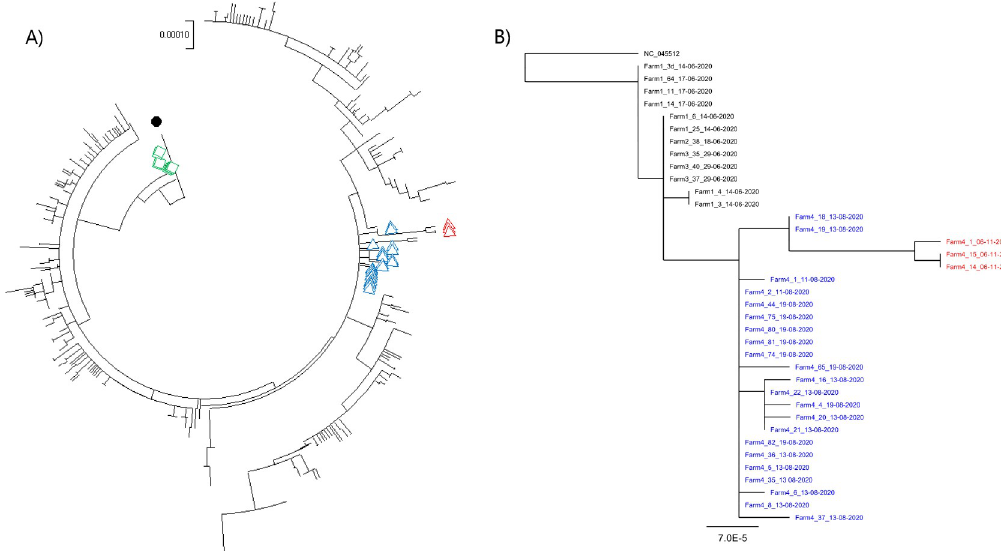
Fig 3. Phylogenetic trees showing the relationships between the full genome sequences of SARS-CoV-2 samples from Danish mink farms with the lineage B.1.1.298 variants. Panel A. All known SARS-CoV2 lineage B.1.1.298 genome sequences (436 in total) from Danish mink along with the Wuhan reference sequence (NC_045512.2) were included in this analysis. Sequences from the re-infection on Farm 4 (collected in November) are indicated by open red triangles while samples collected in August are indicated by blue triangles. Sequences from Farm 1 are indicated with green squares and the Wuhan reference strain with a black filled circle. The GISAID accession IDs are listed in S1 Table. Panel B. The Maximum Likelihood phylogenetic relationships between the viruses collected on Farm 4 and those from Farms 1–3 are shown. The GISAID accession IDs are listed in S2 Table.